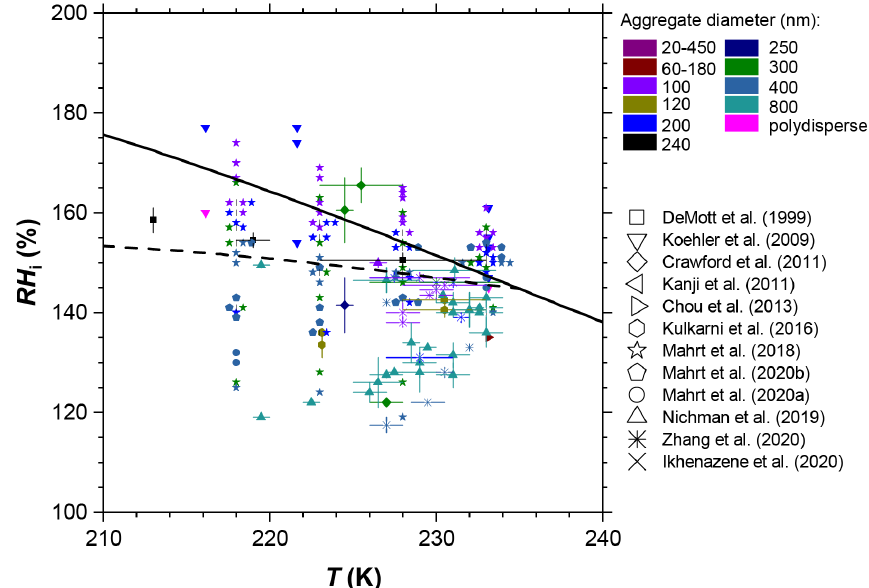
Figure 1. Summary of ice nucleation onset conditions for soot aggregates of different type and size. The ice onset is defined as the relative humidity with respect to ice (RH i ) and temperature ( T ), for which the (ice) activated fraction (AF) reaches 1% of the total soot particle number concentration. Data are compiled from different studies, as indicated in the legend, and constrained to ice nucleation experiments on uncoated soot particles and experiments where values of AF = 1% were reached and respective RH i and T conditions were reported and/or directly accessible from the data presented (see Table F1 for a full list). The solid black line indicates water saturation according to the parameterization of Murphy and Koop (2005), and the black dashed line indicates conditions for homogeneous ice nucleation of solution droplets according to Koop et al. (2000). Overlapping data points are shown horizontally separated from each other with the onset conditions marked by small grey lines. Vertical error bars indicate the range of RH i values over which ice formation onset was observed in the respective studies when multiple experiments with the same soot type and size were performed at the same temperature. Conversely, horizontal error bars denote the T range when multiple ice nucleation experiments covered different temperatures and the reported onset RH i was within the experimental